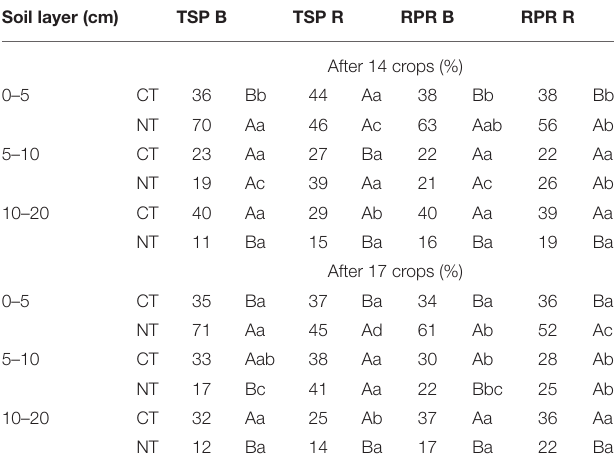
TABLE 2 | Crop sequences and sampling moments in the experimental area. Crop number